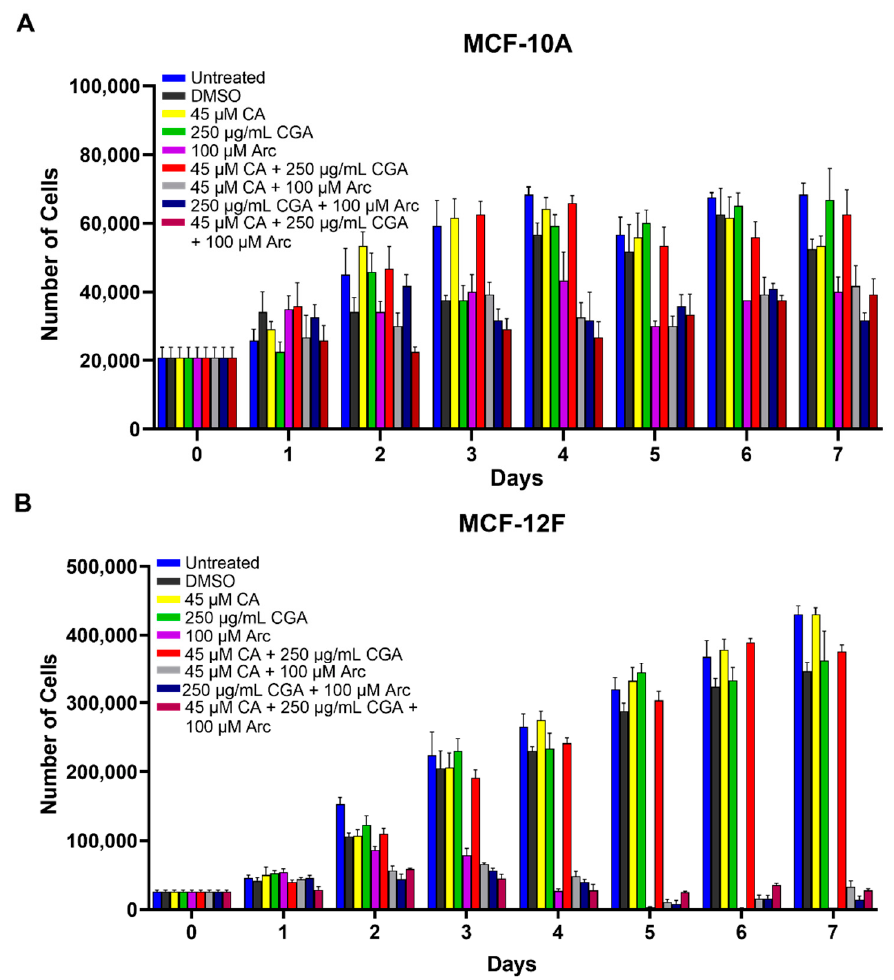
Figure 4. Normal mammary epithelial cell growth curves of ( A ) MCF-10A and ( B ) MCF-12F cells treated with 45 µ M of CA, 250 µ g/mL of CGA, and 100 µ M of Arc, alone and in combination. Cell growth was determined by counting the number of cells in each group on each day for 7 days. Each bar represents the mean ± SEM of three biological replicates ( n = 3). The groups were compared using a one-way ANOVA. The results of the statistical analysis are summarized in Tables S7 and S8. Cell growth differences between groups were considered significant at p ≤ 0.05.